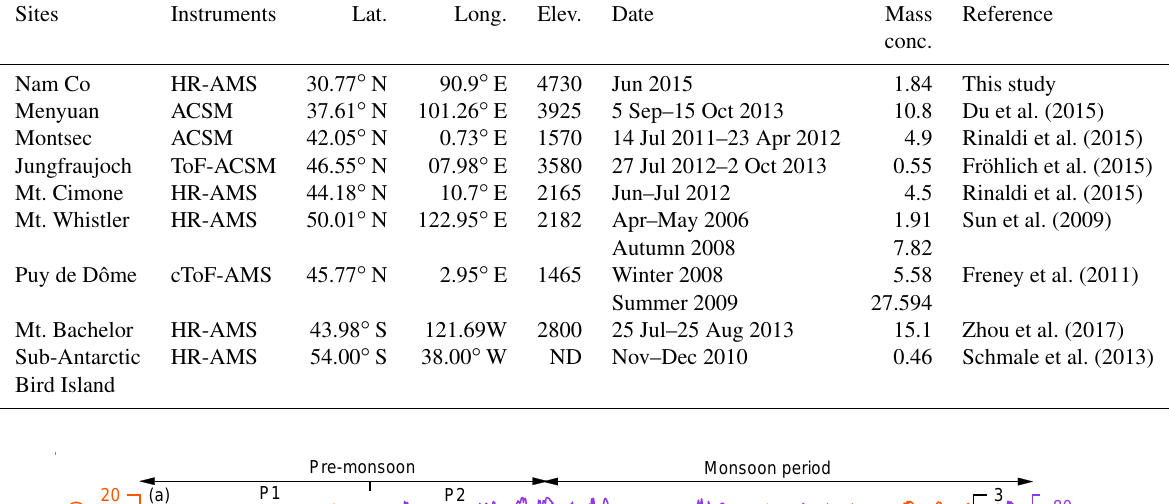
Table 1. Summary of AMS measurement at high-elevation sites around the world. The mass concentration was for NR-PM 1 . Sites